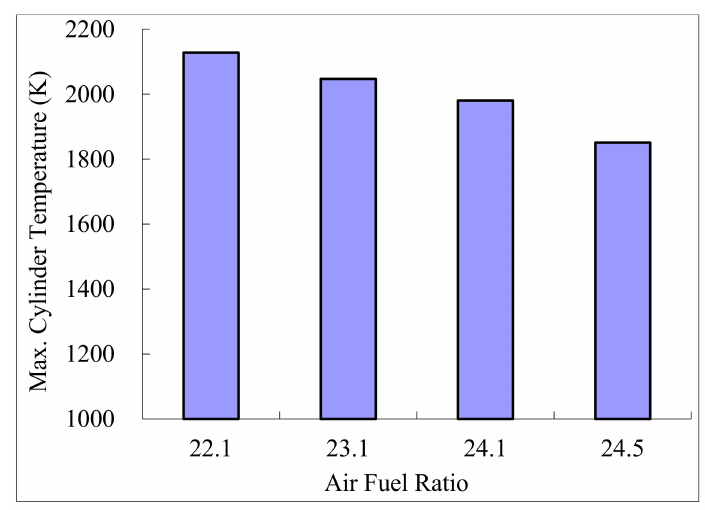
Figure 3. The influence of AFR on the maximum cylinder gas temperature.